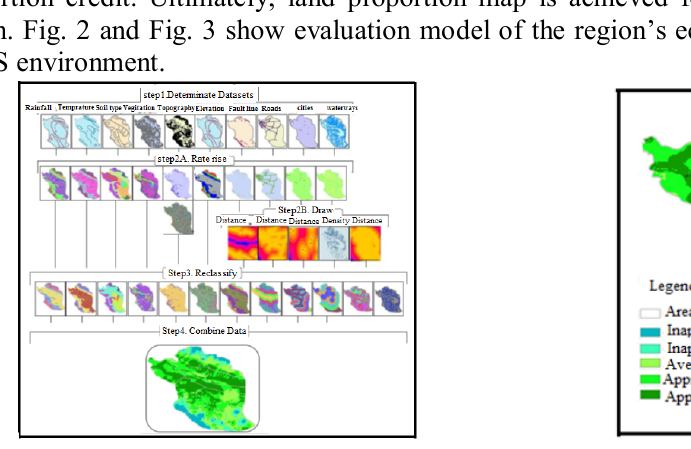
Fig. 3. Ecotourism potentials Isfahan